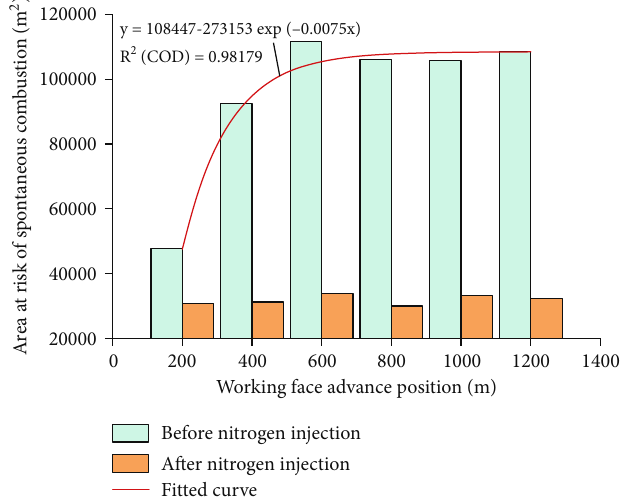
Figure 13: Changes in area of spontaneous combustion risk areas in the goaf.